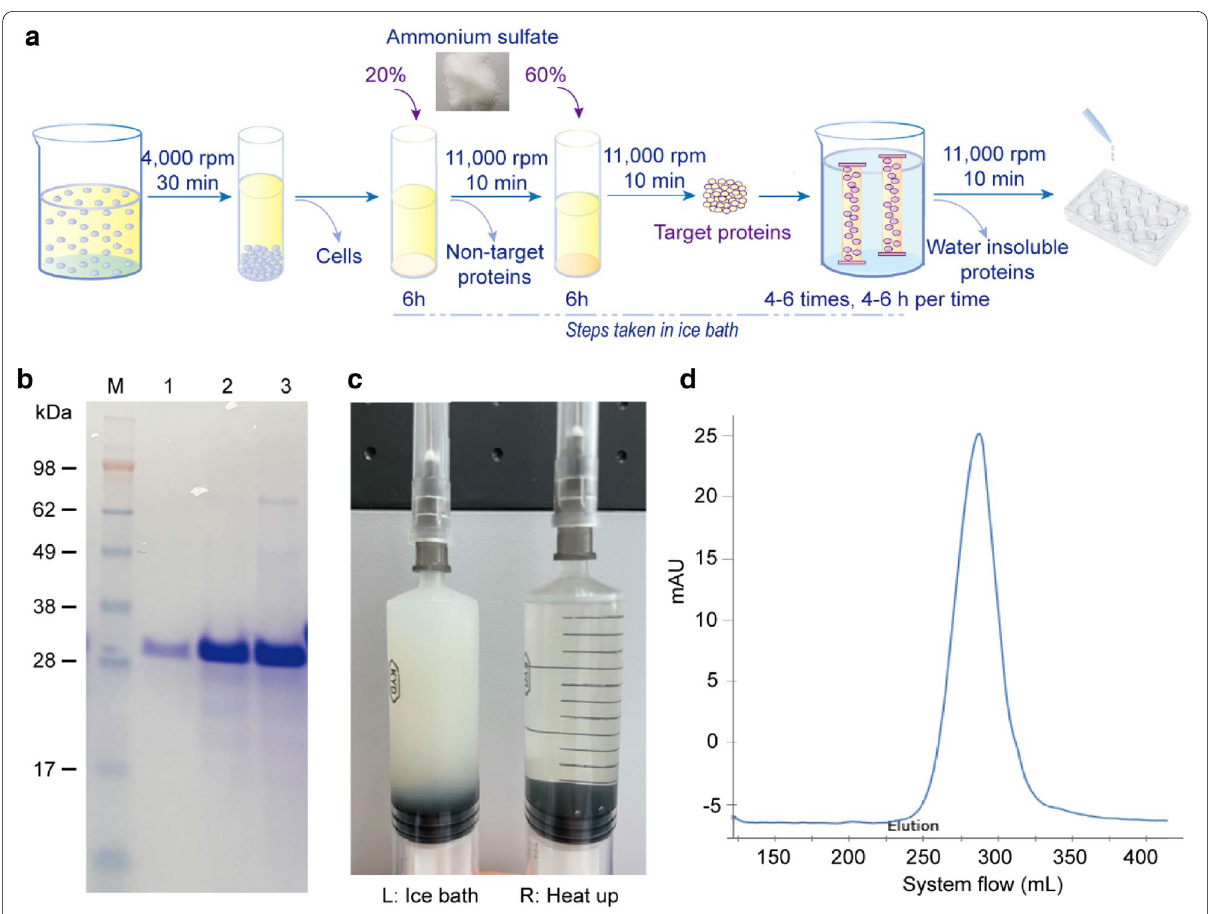
Fig. 2 Purification process of RHLC and purity identification. a Purification process of RHLC fermentation broth. b SDS–PAGE of purified RHLC. Lane 1 was origin fermentation broth, lane 2 was purified RHLC, and lane 3 was redissolved of freeze-dried RHLC. c Different states of RHLC at different temperatures (Left was in ice bath and right was at room temperature). d Gel filtration analysis of redissolved freeze-dried RHLC samples, with 98% purity